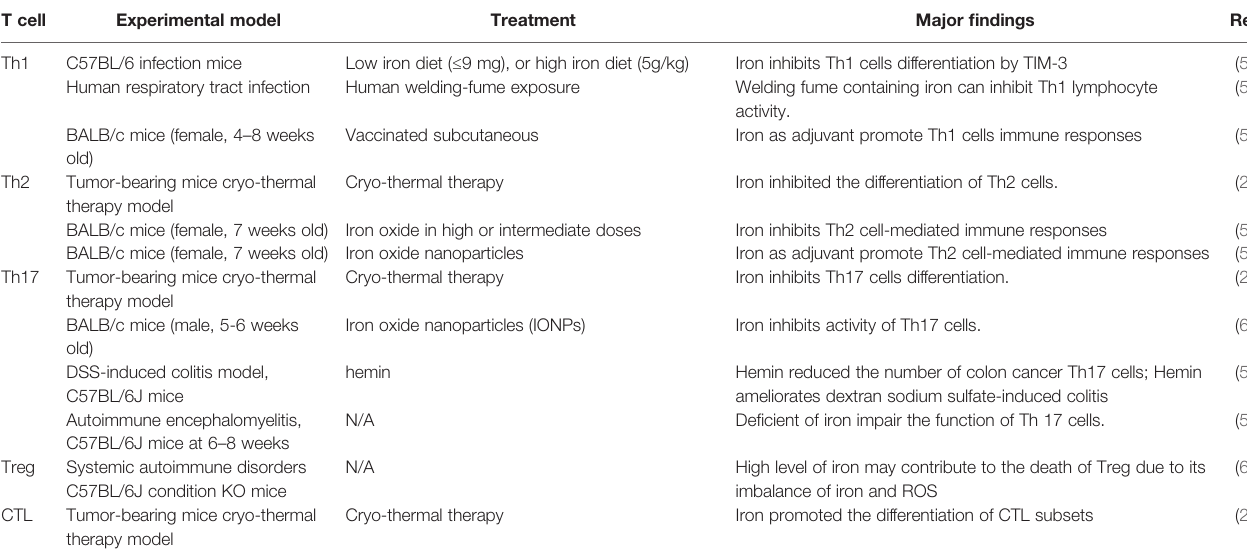
TABLE 3 | Iron and T cells differentiation and